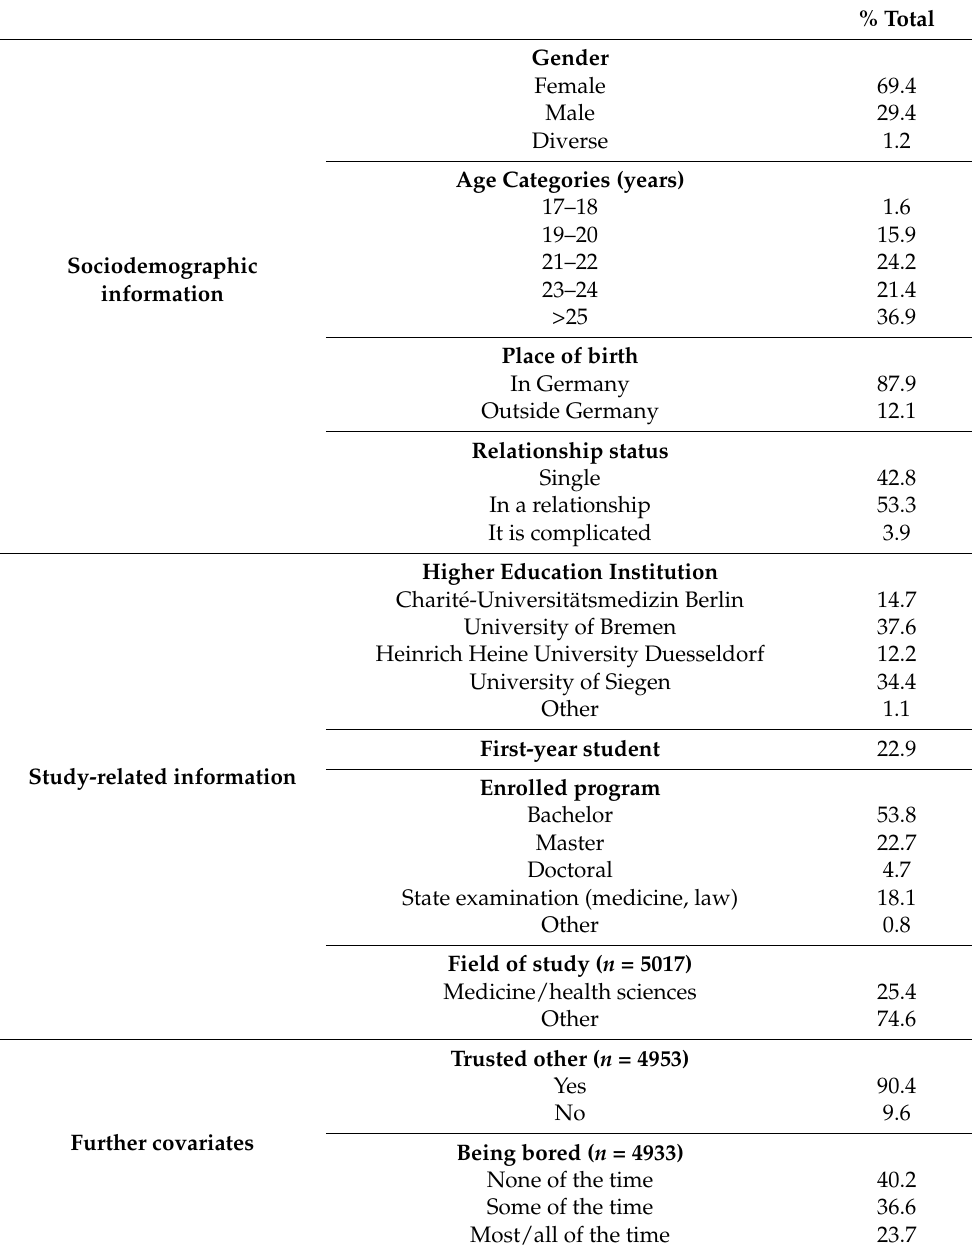
Table 1. Baseline characteristics of the study sample (N =